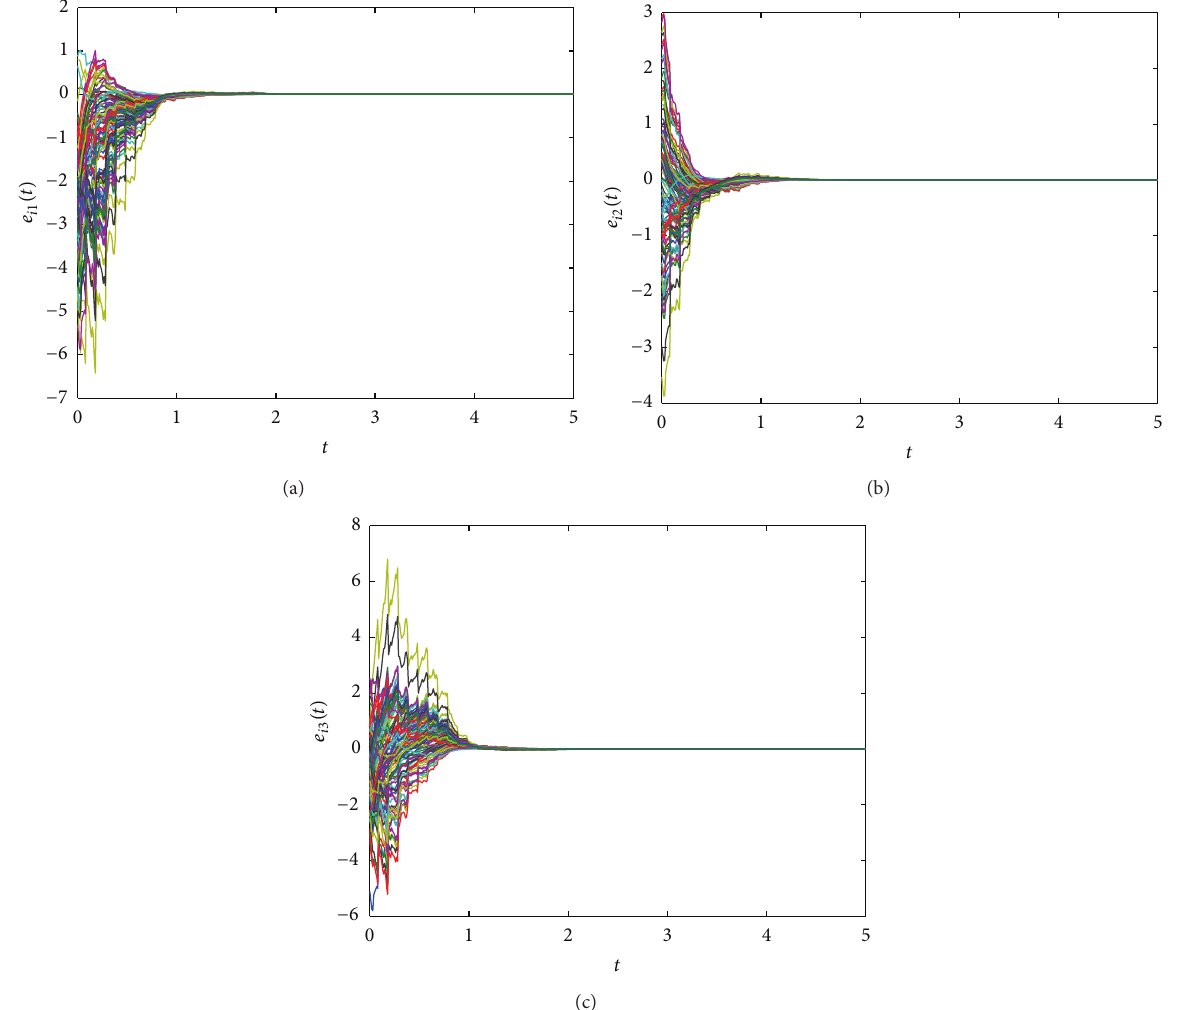
Figure 3: Error variables 𝑒 𝑖 (𝑡) = 𝑥 𝑖 (𝑡) − 𝑠(𝑡) , 𝑖 = 1, 2,. .. ,100 of the coupled dynamical network with impulsive disturbances when |𝜇| < 1